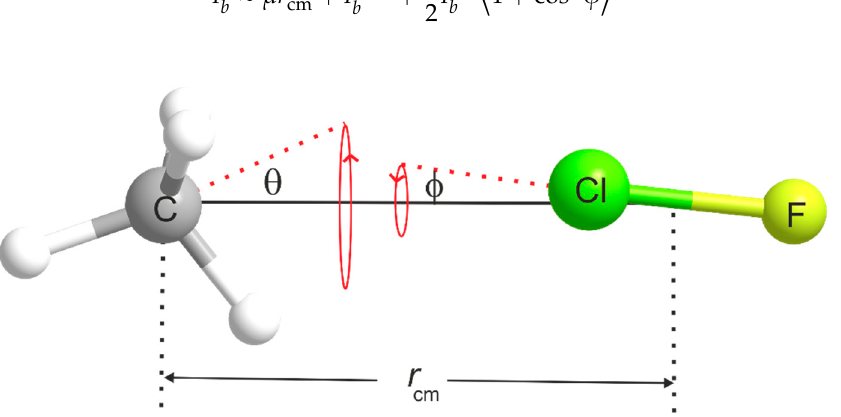
Figure 5. Definition of the distance r cm and the angles θ and 𝜙 used to determine the geometry of H 4 C ··· ClF from the spectroscopic constants recorded in Tables 1 and H 4 C  ClF from the spectroscopic constants recorded in Tables 1 and 4. Table 3. Distances r cm and r (C  Cl), oscillation amplitudes 𝜙 av =cos (cid:2879)(cid:2869) 〈 cos (cid:2870) 𝜙〉 stretching force constants k σ determined for H 4 C  ClF a .